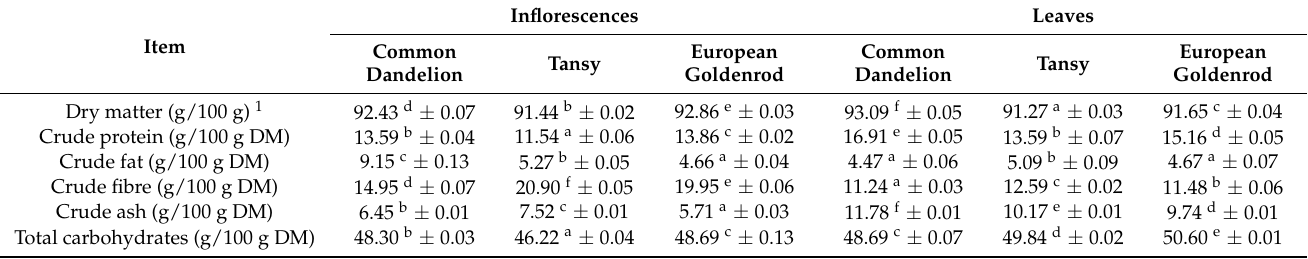
Table 3. The proximate composition of Asteraceae family plants (species × parts of plants interaction).